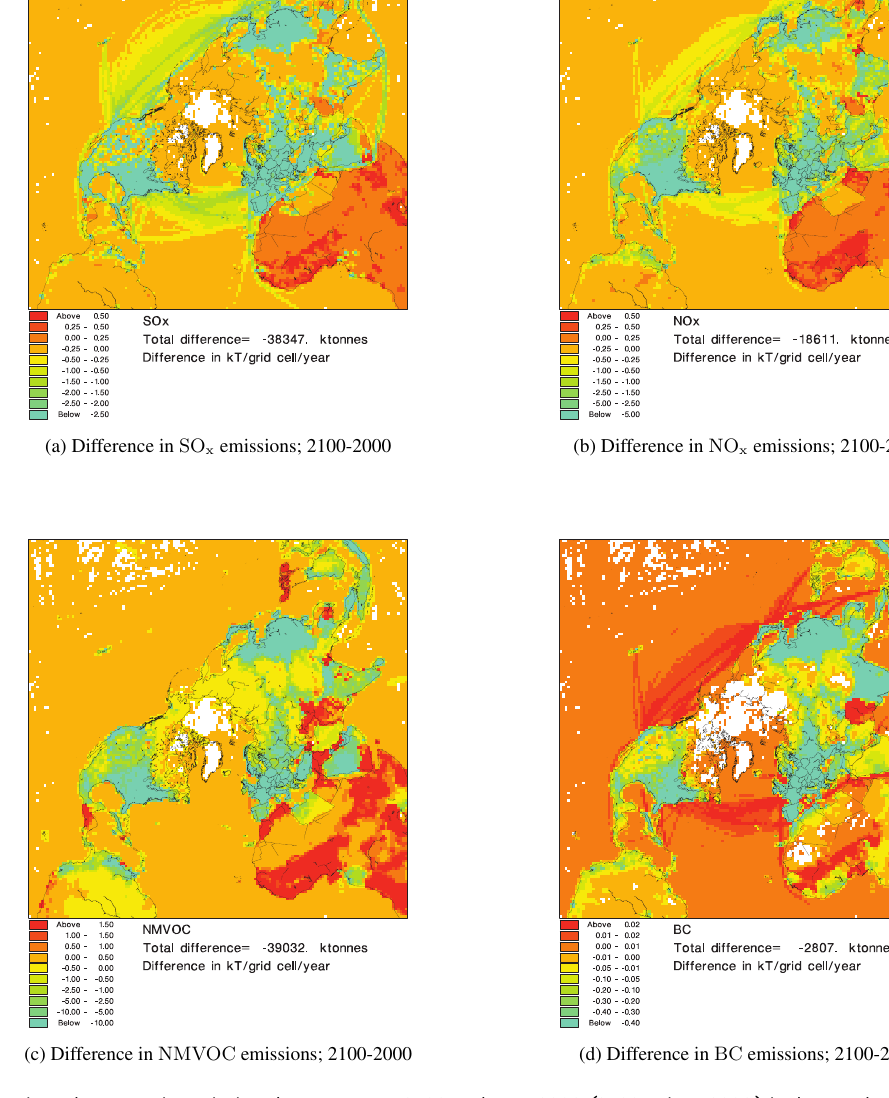
Fig. 3. Difference in anthropogenic emissions between year 2100 and year 2000 (2100 minus 2000) in the Northern Hemisphere projected with RCP4.5 for (a) SO x , (b) NO x , (c) NMVOC, and (d) BC .